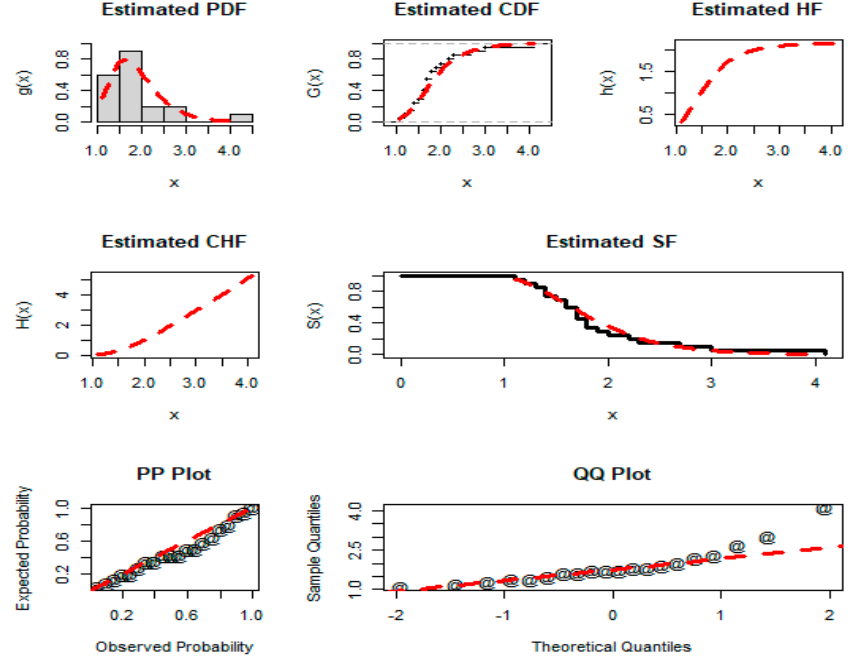
Figure 11. Estimated PDF, CDF, HF, CHF, SF, PP plot, and QQ plot of the NGLog–Weib distribution for dataset 4.